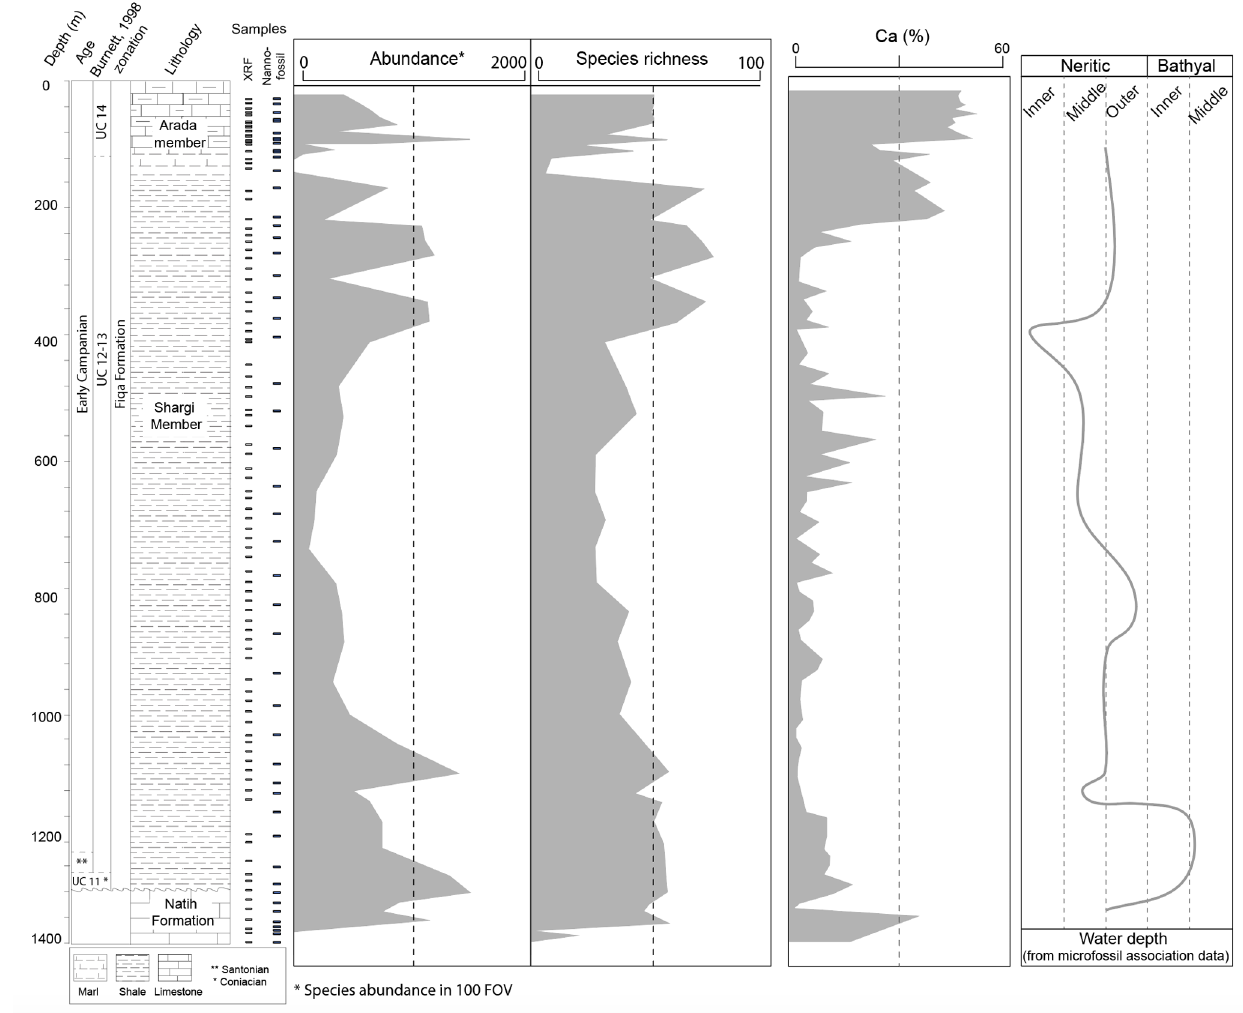
Figure 3. Nannofossil abundance and diversity in the Fiqa Fm. compared to Ca wt% and palaeo-depth,